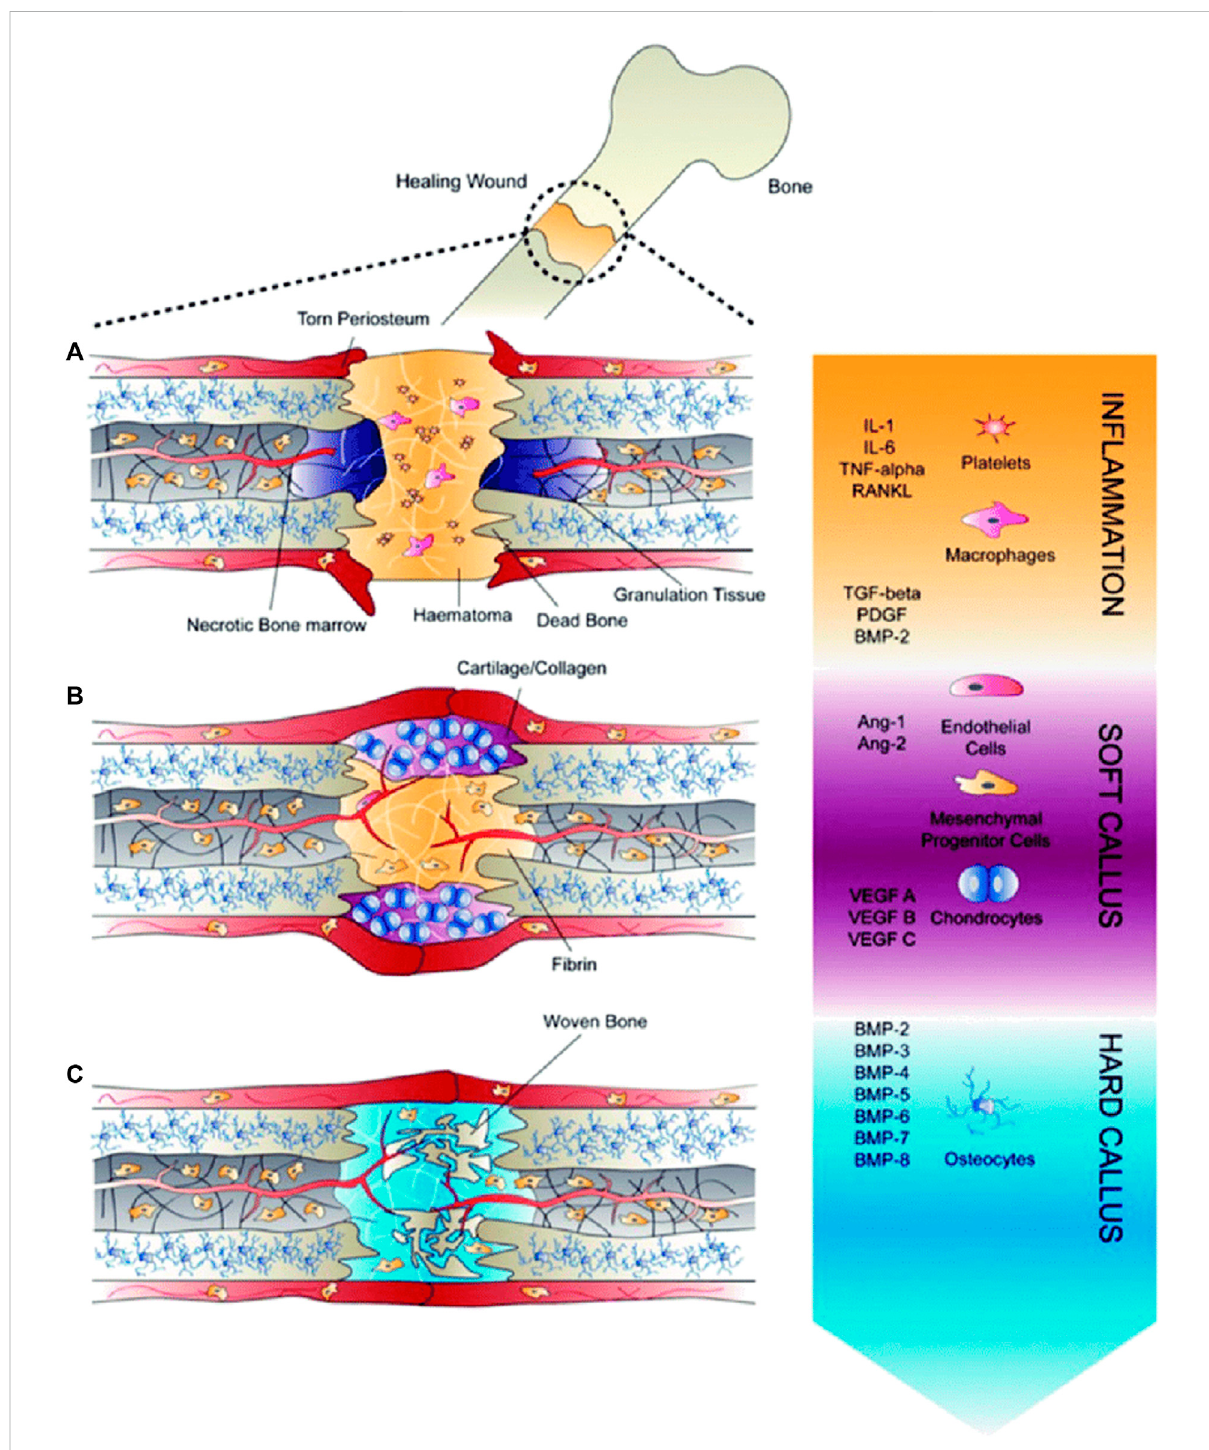
FIGURE 3 Healing of fractures (A) In fl ammatory phase, (B) Soft callus development, during which angiogenesis occurs, and (C) Hard callus formation, duringwhichgrowthfactorsinducedifferentiationofrecruitedmesenchymalprogenitorcells(ReproducedwithpermissionfromRef(DeWitteetal., 2018) under Creative Commons Attribution License (CC